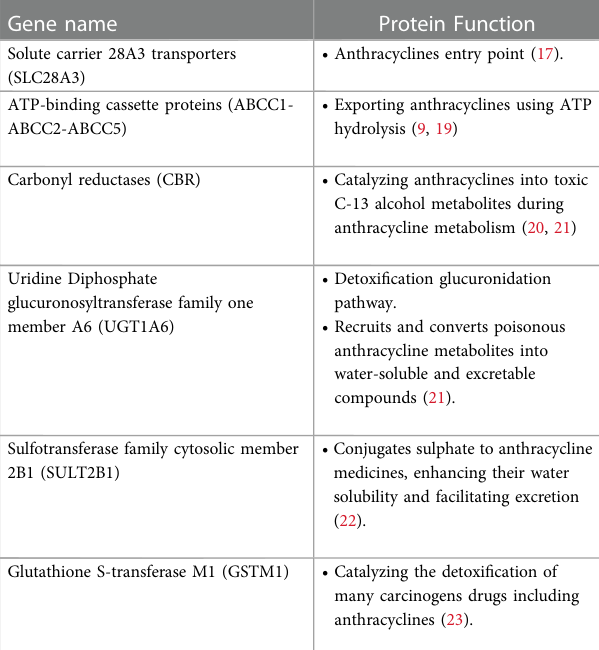
TABLE 1 Prominent genes involved in anthracyclines